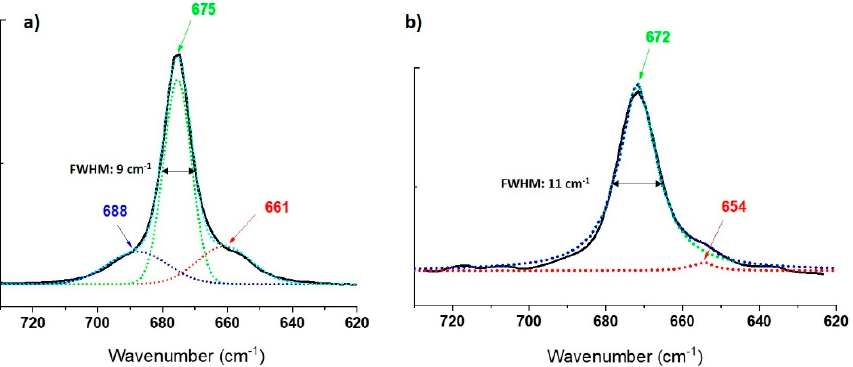
Figure 11. ( a ) Gaussian deconvolution of the asymmetric band at 675 cm − 1 on the Raman spectrum of pure tremolite, three components were identified at 688, 675 and 661 cm − 1 (dash lines); black line experimental band; ( b ) Lorentzian deconvolution of the asymmetric band at 672 cm − 1 on the Raman spectrum of Ni-doped tremolite (run TN8), two components were identified at 672 and 654 cm − 1 ; black line experimental band. FWHM = full width at half maximum.